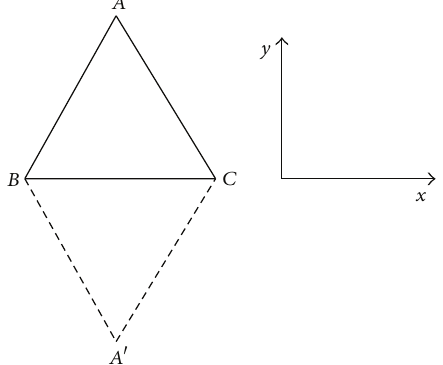
Figure 2: Two equilateral triangles in aperture plane.